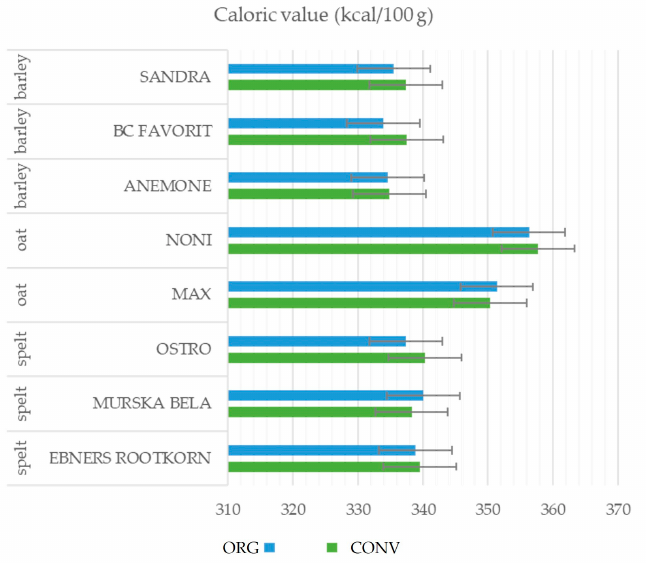
Figure 3. Effects of field management practice (ORG, organic; CONV, conventional) and variety on the caloric value (kcal/100 g) of barley, oat, and spelt groats. LSD 5% values showing the differences between the field management practices.